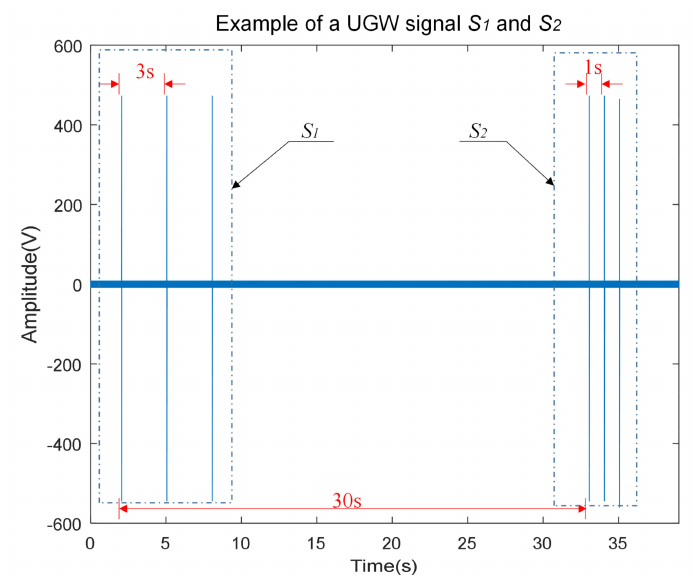
Figure 4. Example of UGW signals S 1 and S 2